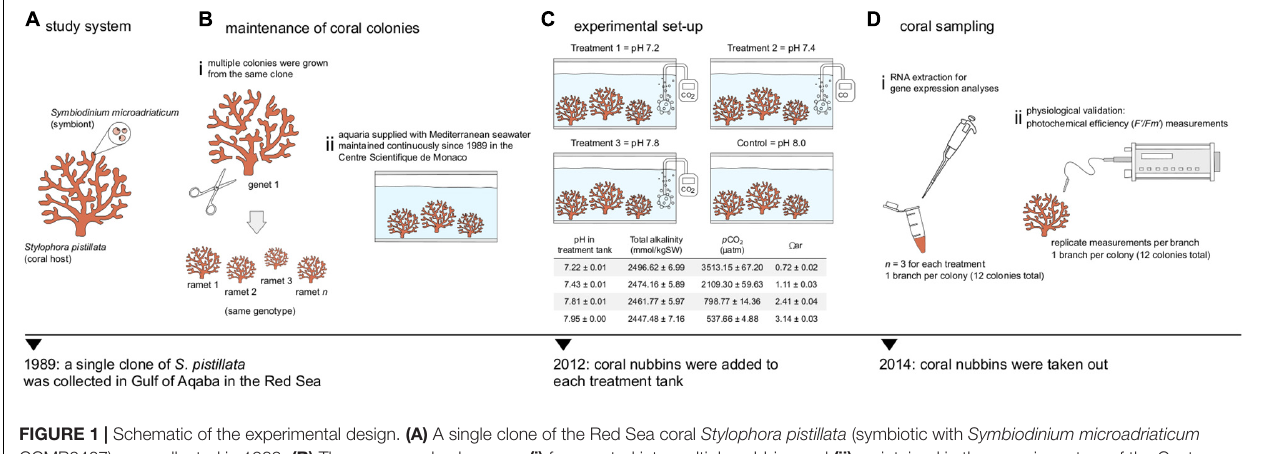
Frontiers in Microbiology |